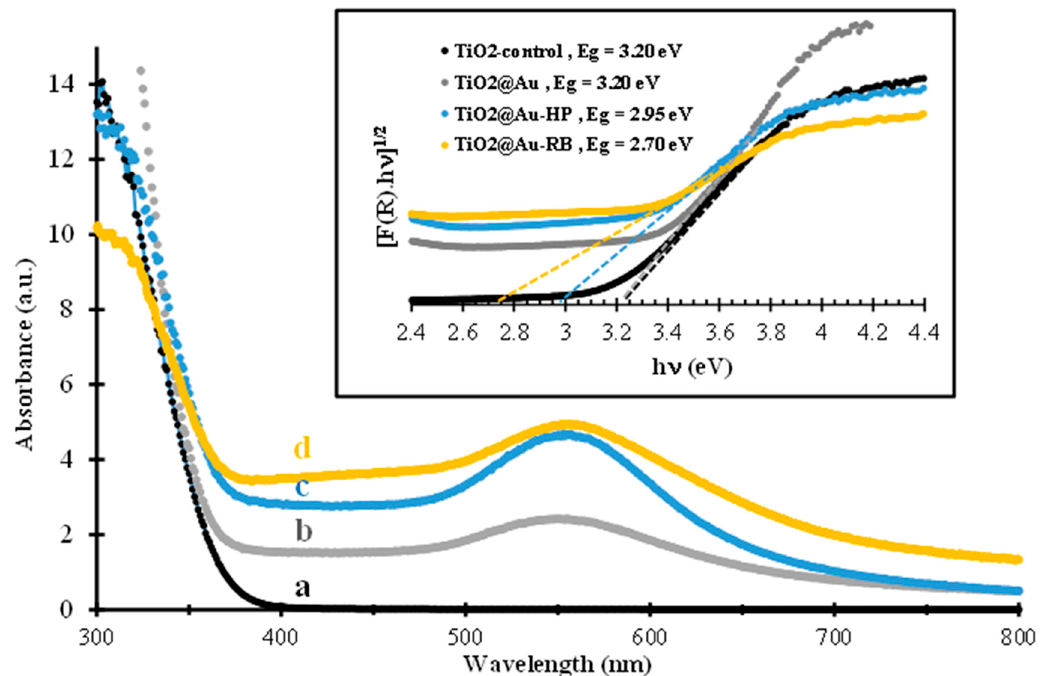
Figure 5. Diffuse Reflectance UV-Vis (DRUV-Vis) spectra of titania-based materials prepared by microwave heating: ( a ) bare TiO 2 , ( b ) TiO 2 @Au, ( c ) TiO 2 @Au-HP, ( c ) and ( d ) TiO 2 @Au-RB. In the inset, Tauc plots for the determination of the band gap values Tauc (indirect bad gap energy).